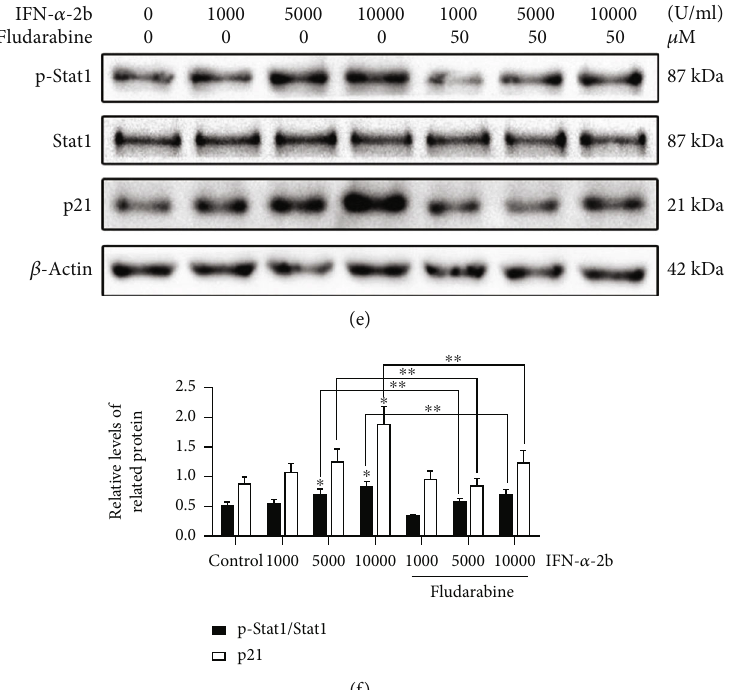
Figure 5: The inhibitory e ff ect of IFN- α -2b on the proliferation of fi broblasts by STAT1/P21 signaling pathway. (a) After treating fi broblasts with IFN- α -2b or combined with fl udarabine, perform EdU staining to analyze the result image. The cells shown in red are marked as positive. (b) The results of the EdU incorporation test showed that as the concentration of IFN- α -2b increased, the percentage of positive cells decreased signi fi cantly. This trend was partially reversed by fl udarabine. (c, e) Western blotting shows the increase of PCNA, cyclin A, and collagen I and predicts the expression levels of related pathway proteins. (d, f) The analysis results showed that IFN- α -2b signi fi cantly reduced the relative expression levels of PCNA, cyclin A, and collagen I in a concentration-dependent manner, while increasing the relative expression levels of P-STAT1 and P21. And after fl udarabine application, the trend of action was partially reversed. The histogram shows the results of three repeated detections of the gray value of the Western blot band. ∗ Compared with the control group. ∗∗ Compared between the two groups, P < 0 : 05 ( n = 3